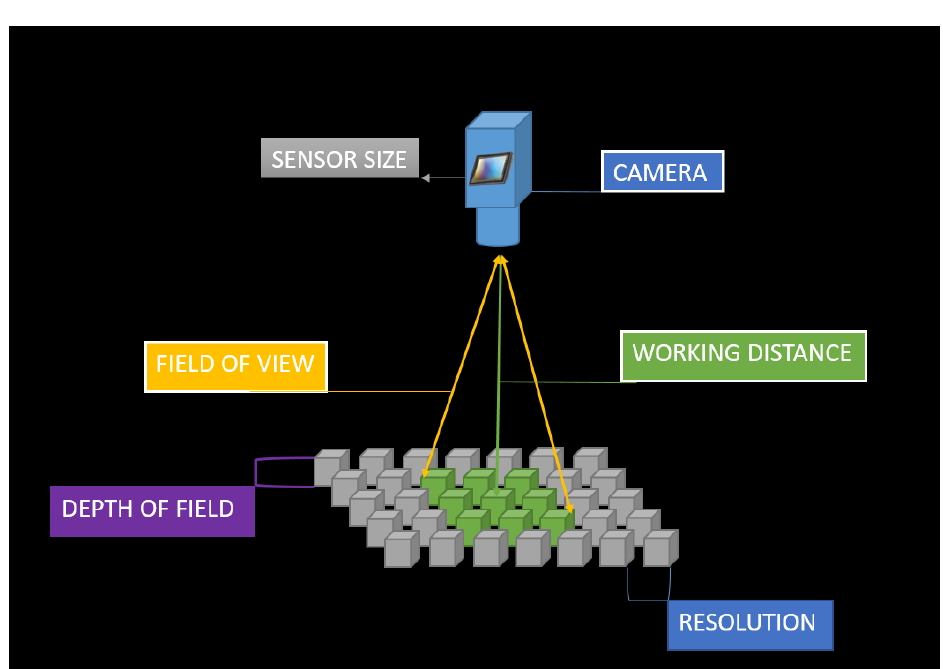
Figure 9. Basic parameters of an Imaging System.